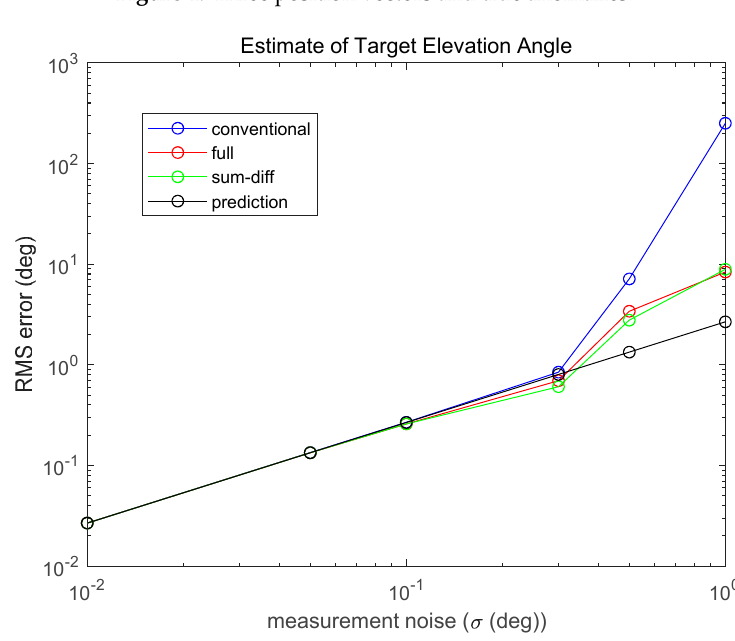
Figure 5. Three position vectors and true anomalies.